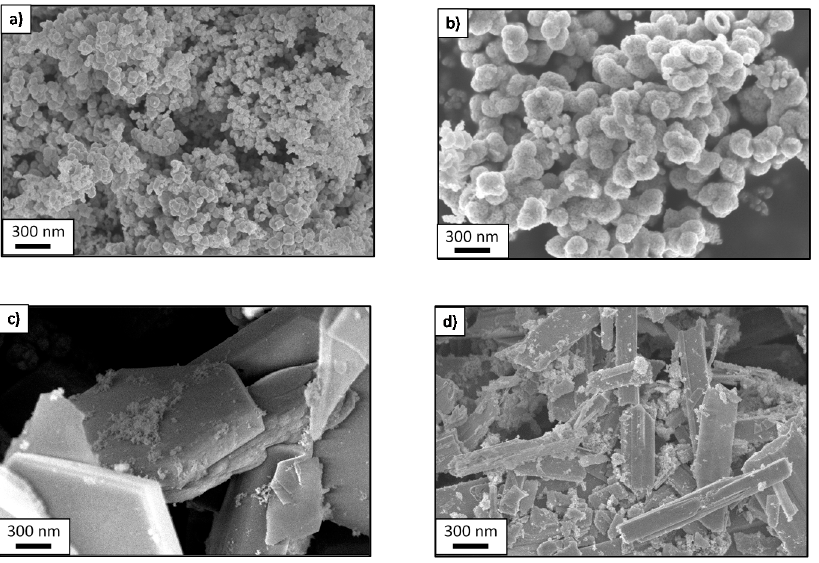
Figure 3. FESEM images of the bismuth sulfides synthesized in ethanol ( a ), acetone ( b ), isopropanol ( c ), and distilled water ( d ).